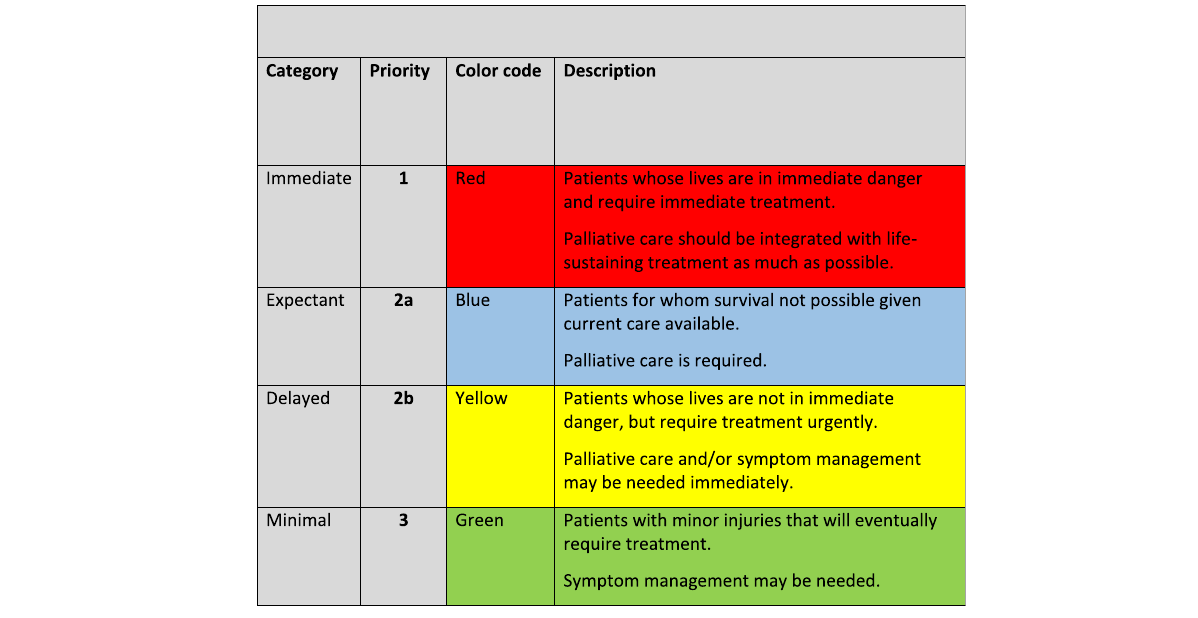
(Source: Adapted from WHO et al.